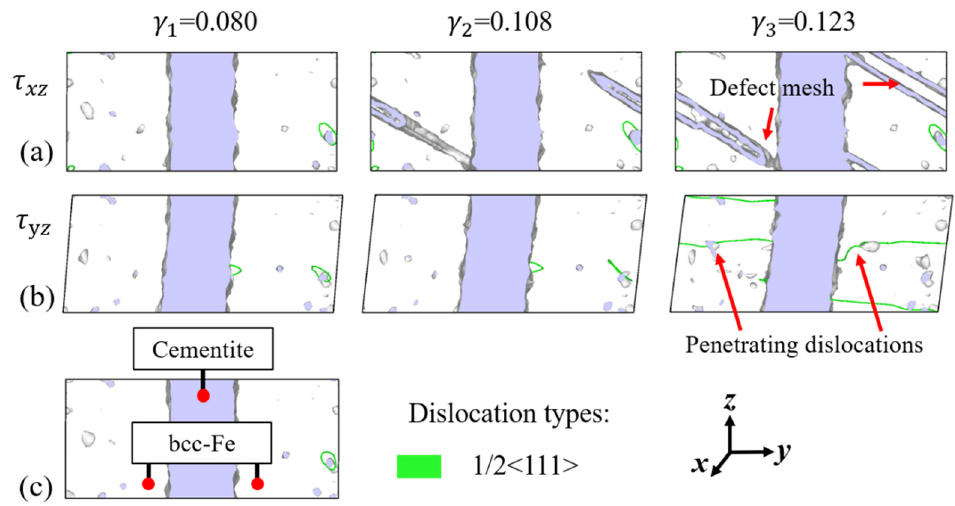
Figure 7. Dislocation distribution in the model under monotonic shear deformation. Shear directions are along ( a ) the x -axis and ( b ) the y -axis, respectively. The initial structure is provided for comparison in ( c ). Green lines in bcc-Fe matrix correspond to 1/2<111> dislocations. Gray planes in bcc-Fe matrix are defect meshes.